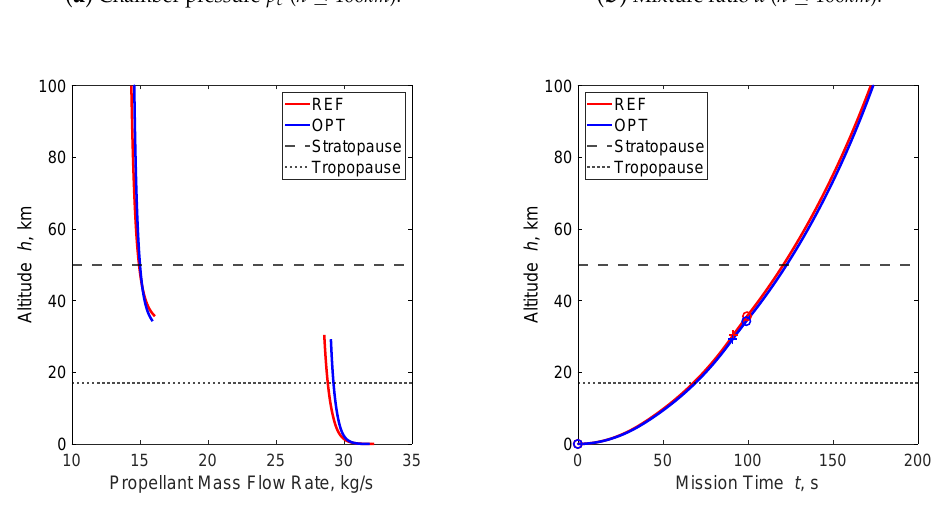
( d ) Mission time t ( h ≤ 100 km ). Circles and crosses represent stages ignitions and shutdowns, respectively. Figure 5. Chamber pressure p c , mixture ratio α , propellant mass flow rate ˙ m p and mission time t trends during the launcher ascent until 100 km altitude. The discontinuities in the plots (at about 30 km altitude) correspond to the coast arc for the first stage jettisoning. Table 4. Comparison of environmental impact indices. EIs units are grams emitted per kilogram of propellant burned. CFP / µ units are kg of CO 2 equivalent emitted per kg of payload mass delivered in the target